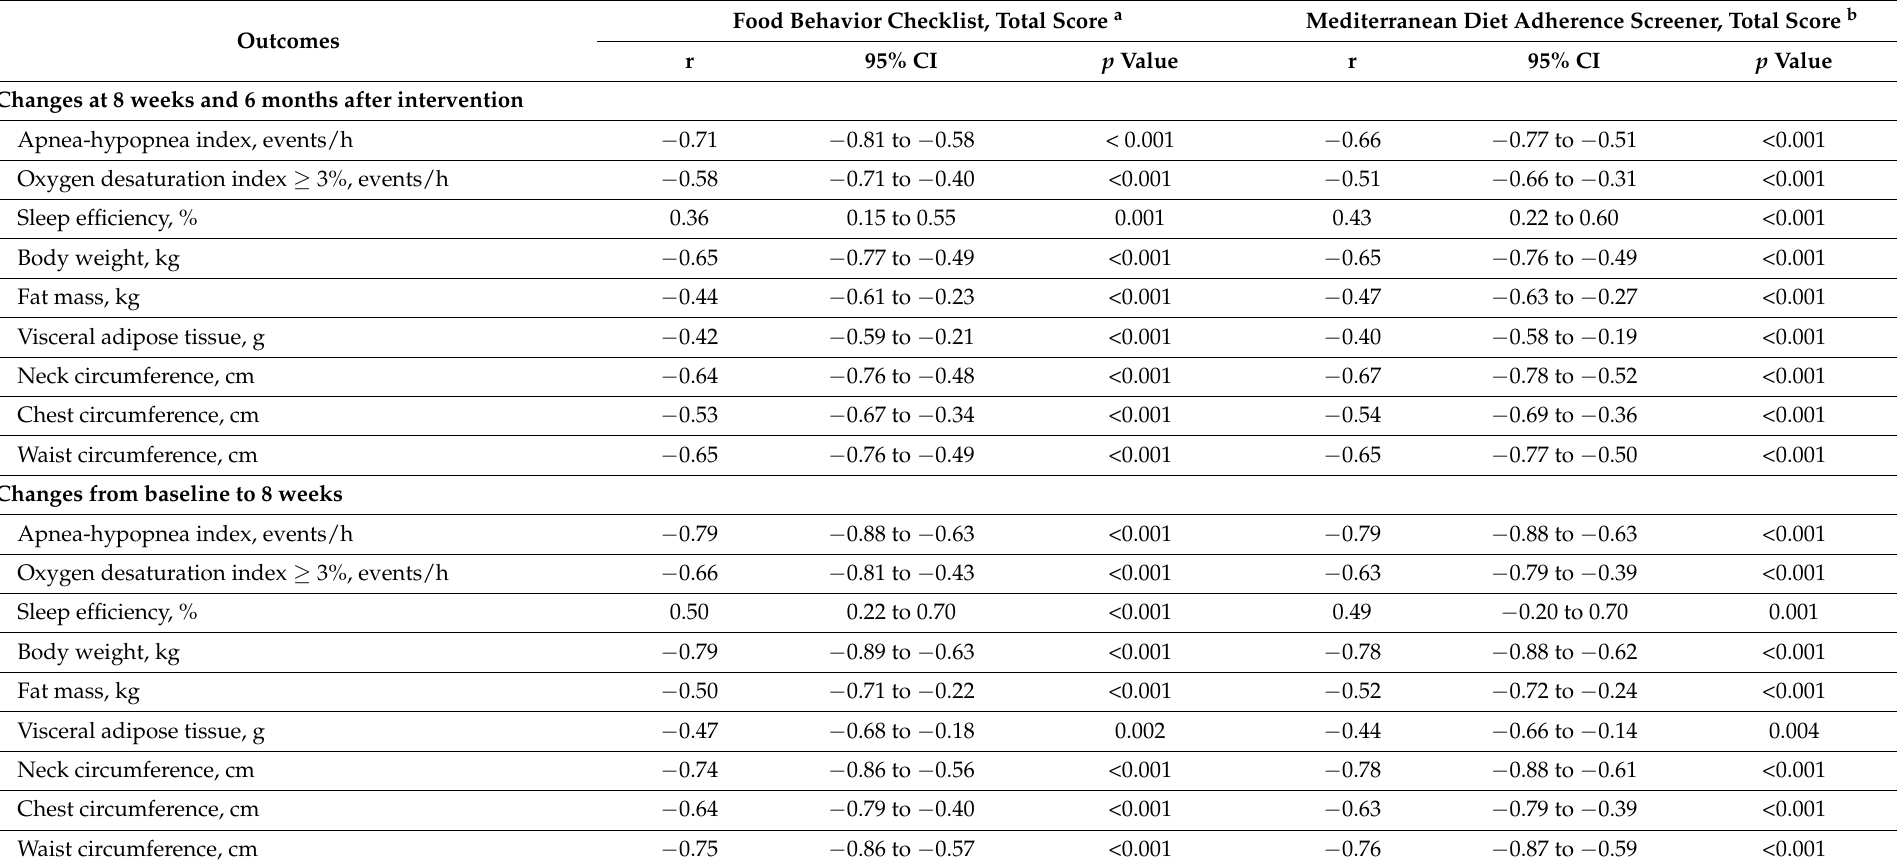
Table 3. Repeated measures correlation analyses examining the association of changes in dietary behavior over time with changes in sleep and body weight and composition